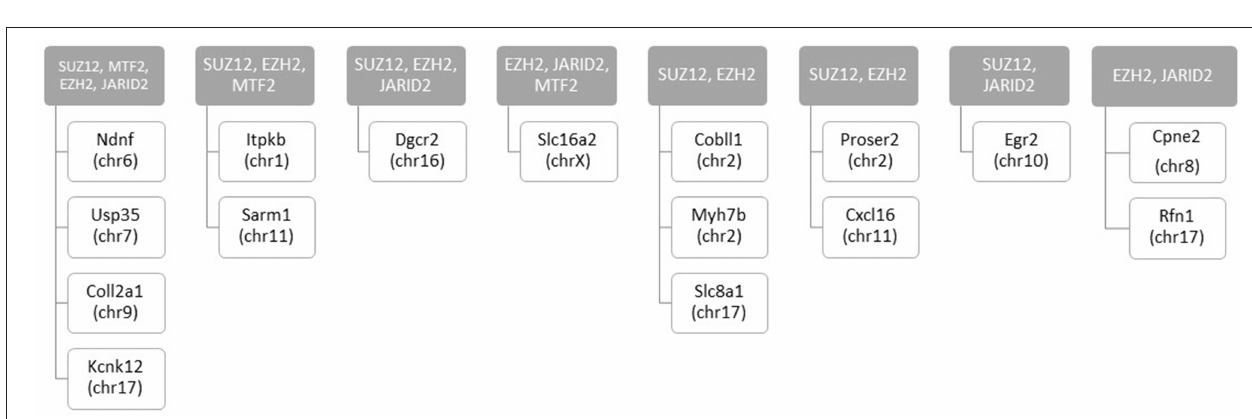
FIGURE 5 | Number of hypermethylated DMRs that are linked to more than one PcG binding sites with continuous exposure. RRBS analysis of effector memory CD4 + T cells from control and continuous TCE exposure revealed 129 statistically significant DMRs from regulatory elements based on ORegAnno database. The hypermethylated DMRs associated with PcG group binding sites ( n = 99) were linked to 16 unique genes associated with more than 1 PcG protein binding